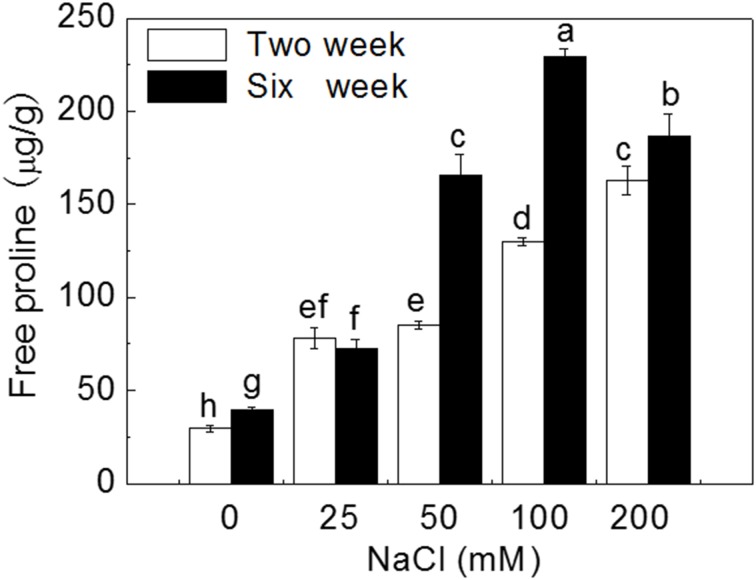
Effects of NaCl treatment on free proline content. Values are means and bars indicate SDs (n = 6). Columns with different letters indicate significant difference by Duncan's multiple range tests at P < 0.05.